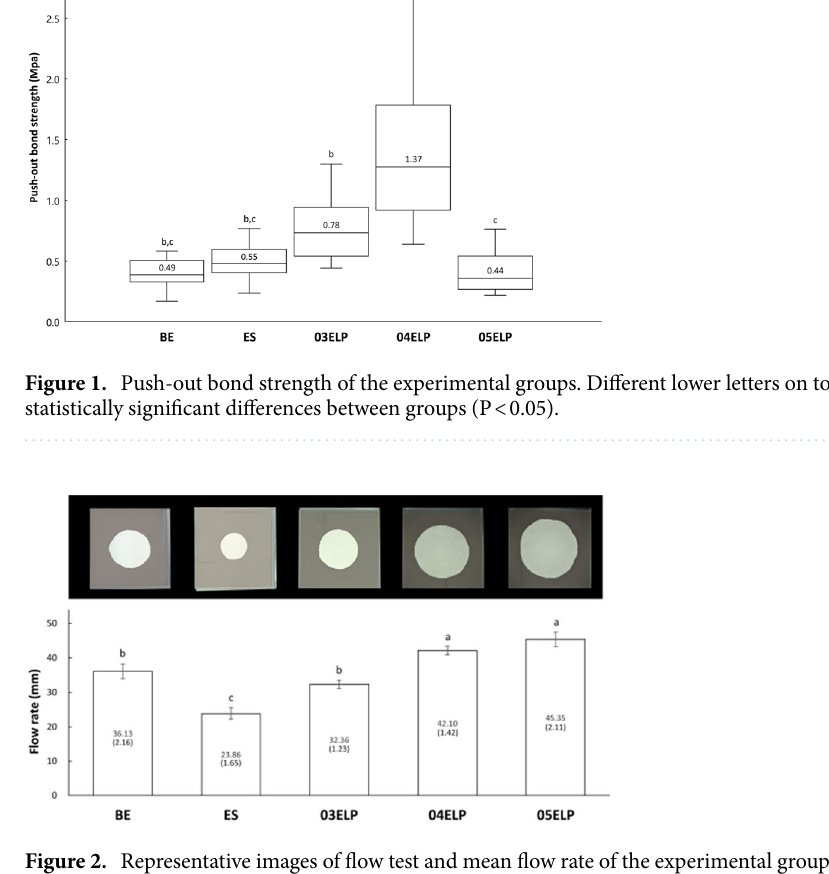
Figure 2. Representative images of flow test and mean flow rate of the experimental groups. Numbers in parentheses present standard deviation values. Different lower letters on top of the bar denote statistically significant differences between groups (P <